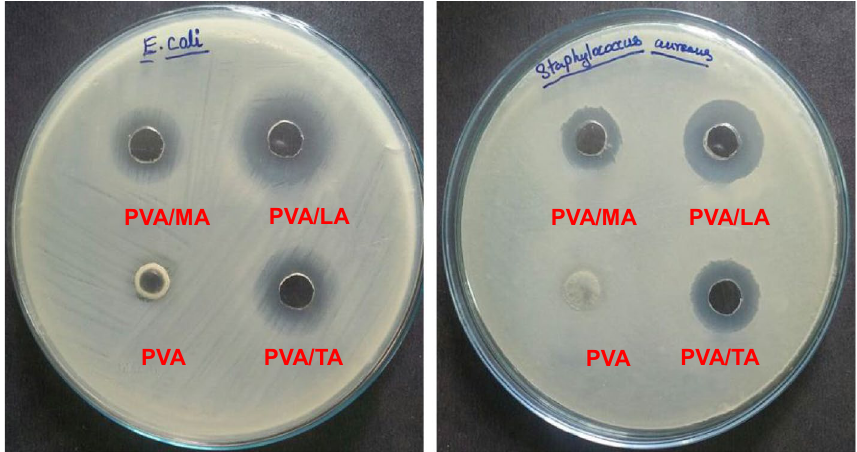
Fig. 9 Antibacterial inhibitory effects of pristine PVA, PVA/ MA, PVA/TA, and PVA/LA polymer solutions